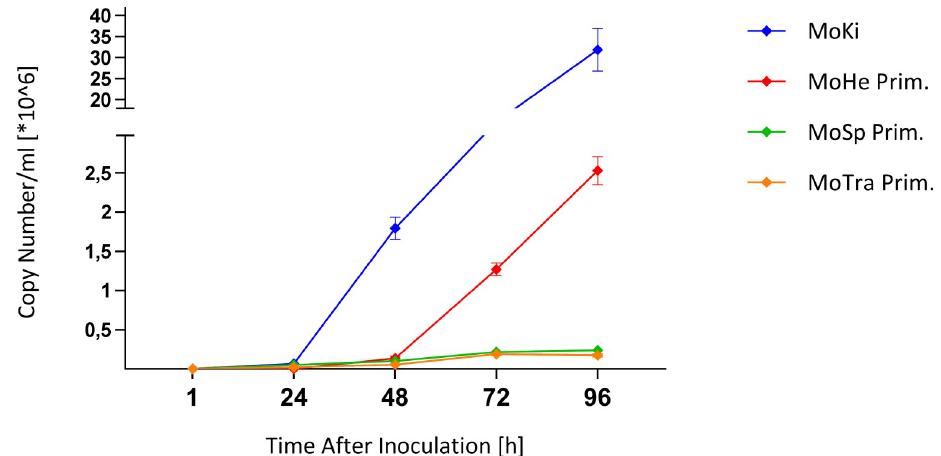
Fig 4. Ebola virus (EBOV) replication kinetics in different M . condylurus cells. Viral genome copy numbers/ml of infected cell cultures from M . condylurus (MoTra Prim, MoSp Prim, MoHe Prim and MoKi) were determined by qRT-PCR. Different levels of EBOV replication: low virus replication in MoTra Prim (orange) and MoSp Prim cells (green), moderate virus replication in MoHe Prim cells (red), high virus replication in MoKi cells